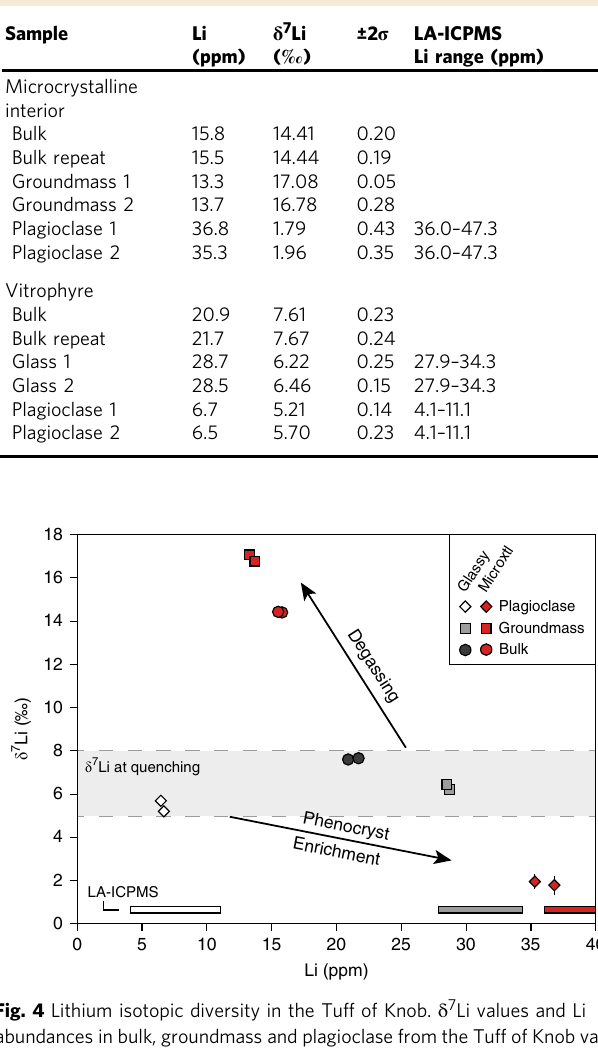
Table 1 Lithium abundance and isotopic composition of bulk rock, groundmass and plagioclase from the Tuff of